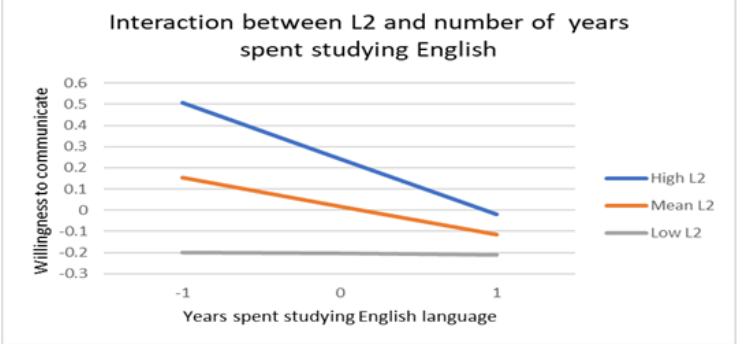
Figure 2. Interaction between ideal L2 self and years spent studying English/German